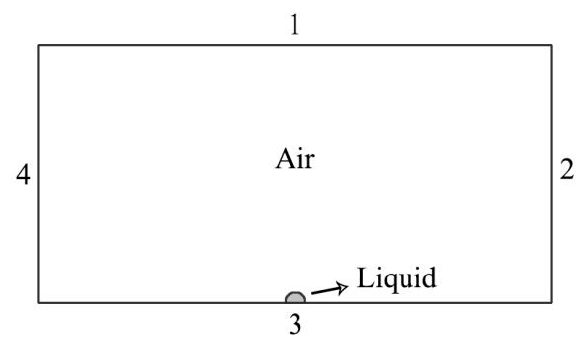
Figure 2. Geometry of the computational domain.